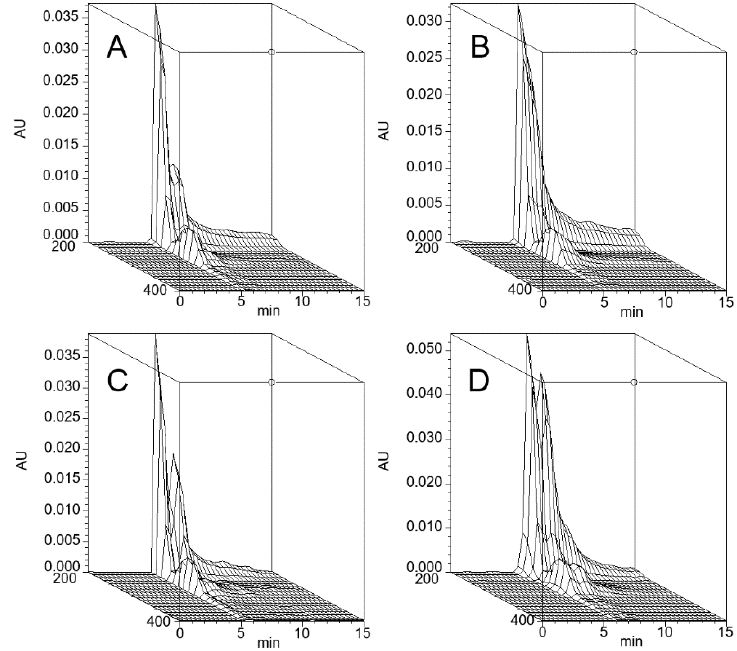
Figure 2. Three-dimensional chromatogram of the stPEG25 / CoQ10 micelle ( A ), stPEG40 / CoQ10 micelle ( B ), stPEG55 / CoQ10 micelle ( C ), and stPEG140 / CoQ10 micelle ( D ). High-performance size-exclusion chromatography was performed using an HPLC system equipped with a photodiode array detector. A 7.8 × 300 mm, TSKgel ® G4000PWXL column was used at 40 ◦ C. The mobile phase was water, and the flow rate was 1.0 mL / min. AU, Absobance